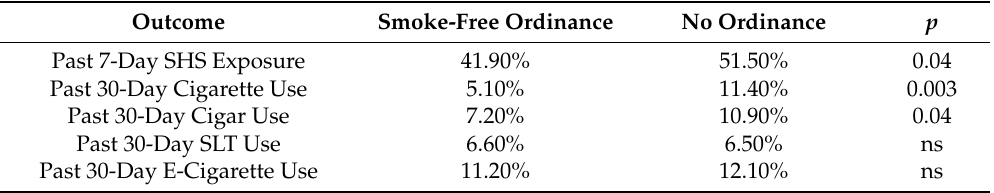
Table 2. SHS exposure and tobacco use by smoke-free ordinance